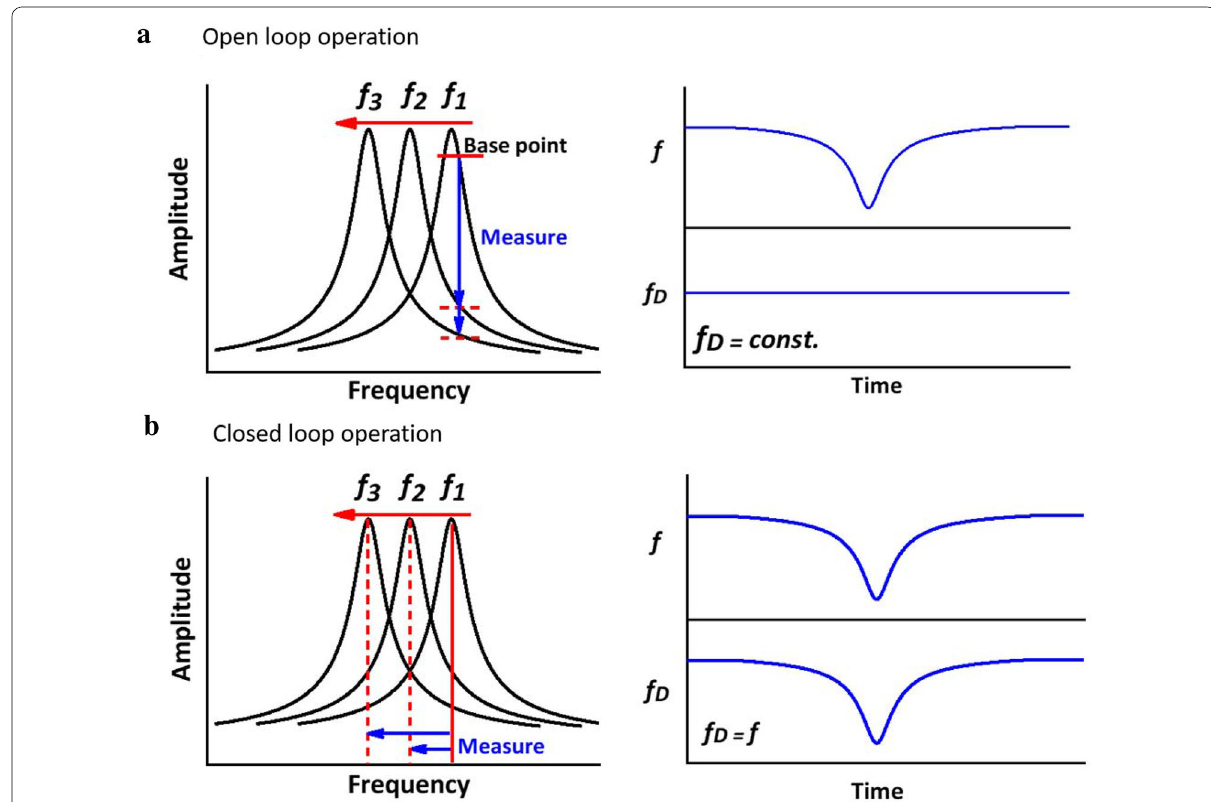
Fig. 2 Open and closed loop operation of mechanical resonators. a Amplitude spectrum (left) and drive and measured resonance frequencies (right) during open loop operation. In this mode, amplitude change and phase shift are measured. b Amplitude spectrum (left) and drive and measured resonance frequencies (right) during closed loop operation. In this mode, frequency shift is